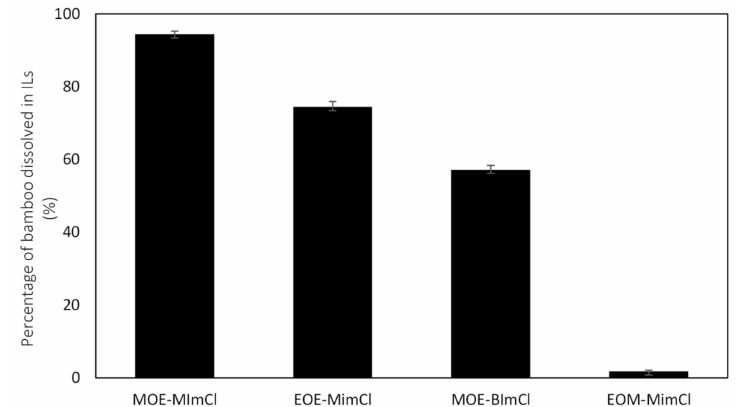
Figure 6. Percentage of bamboo dissolved in ether-functionalized